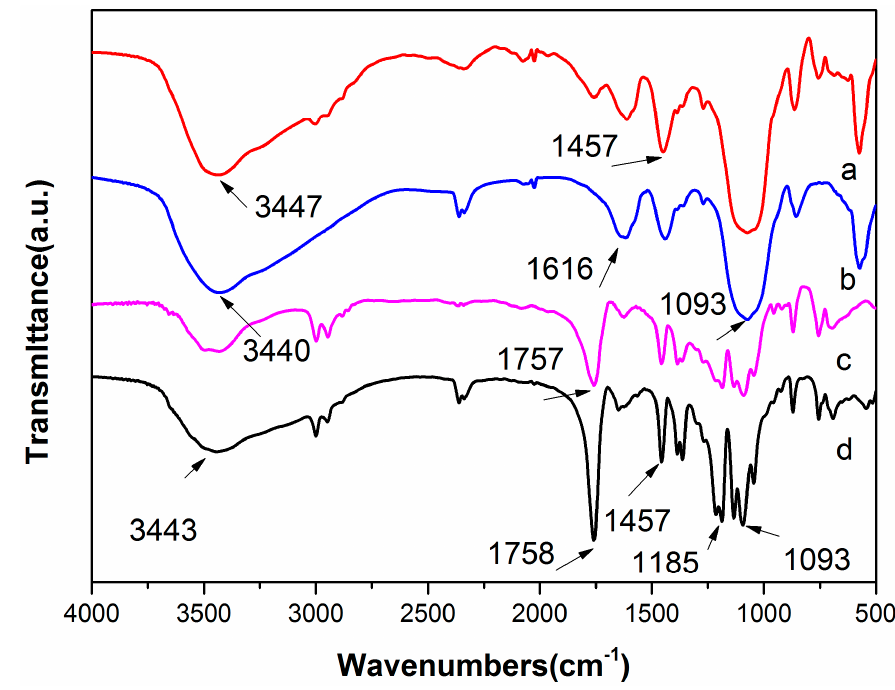
Figure 4. Fourier transform IR (FTIR) spectra of ( a ) PLLA, ( b ) GO, ( c ) GO/PLLA ,and ( d ) GO- g -PLLA